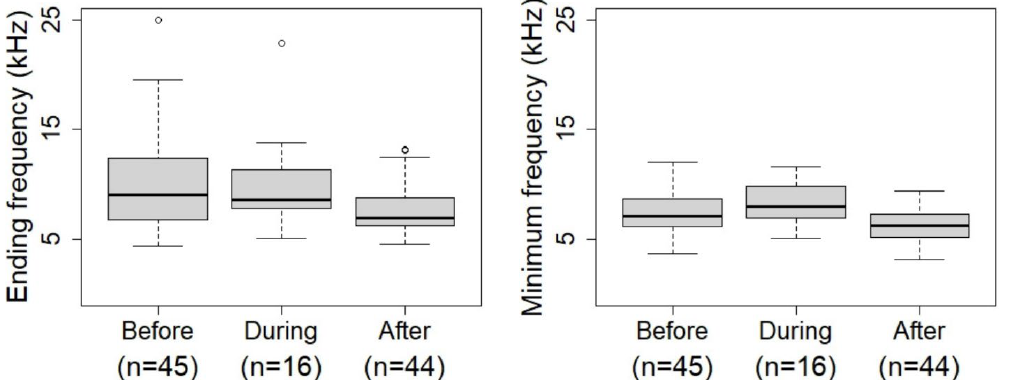
Figure 2. Whistle parameters of the oceanic ecotype significantly different between before approach , during approach and after approach . The ending frequency after approach resulted lower compared to the one before approach and during approach . The minimum frequency after approach was lower compared to the one during approach . The starting frequency of the whistles of the coastal ecotype showed significantly negative correlation with the peak noise difference (τ = − 0.3633924, z = − 1.9703, p < 0.05) (Figure 3). Duration and frequency range of the whistles of the oceanic ecotype showed significantly positive correlation with the peak noise difference (respectively: τ =